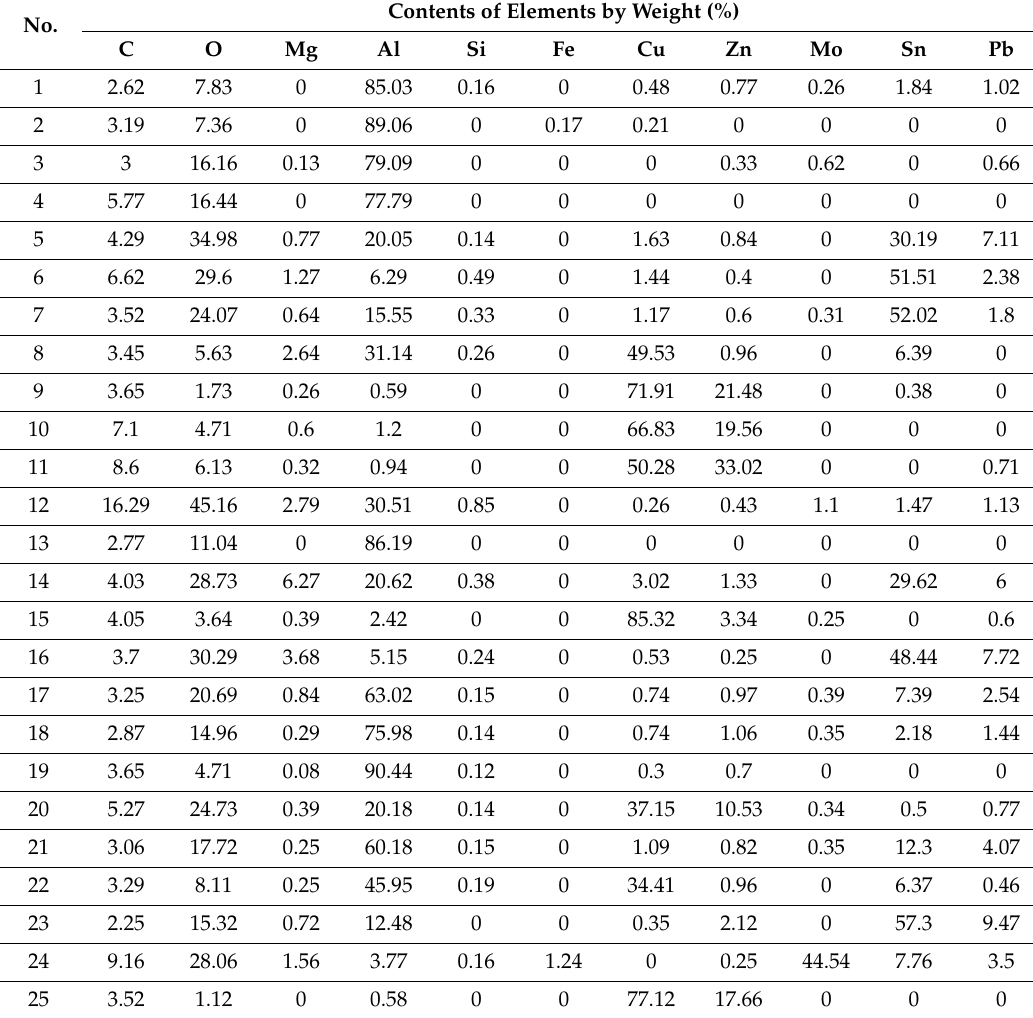
Table 4. EDS chemical identification of elements and their concentration in M2